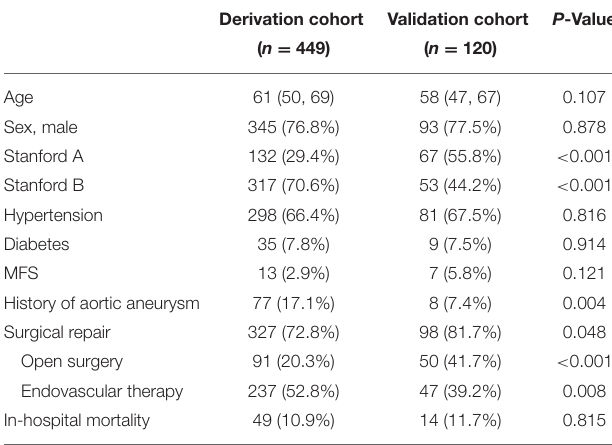
TABLE 1 | Baseline characteristics of AAD patients in the derivation and validation